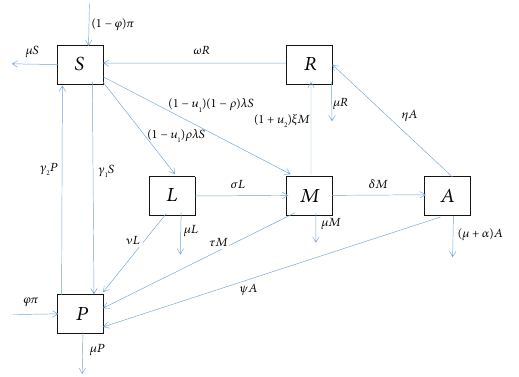
Figure 1: The model compartment for the population dynamics of health risks associated with